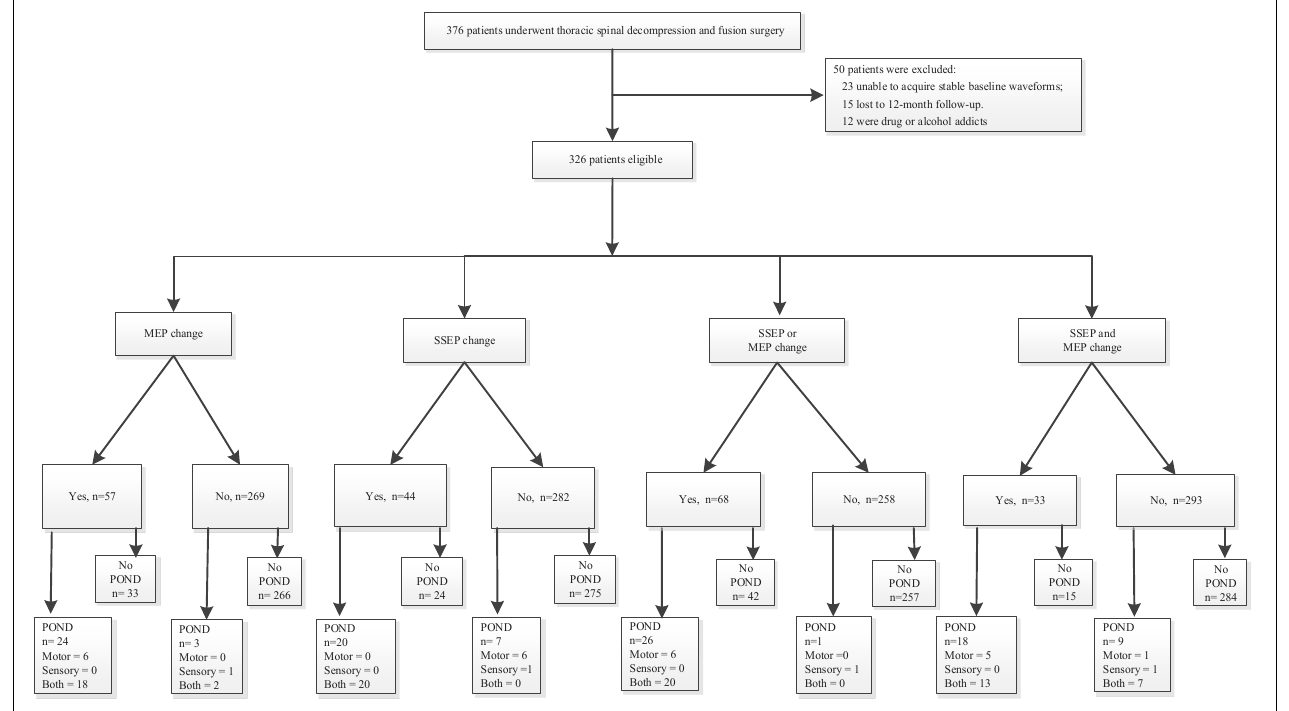
FIGURE 1 | Our study flowchart. PONDs, postoperative neurological deficits; SSEP, somatosensory-evoked potential; MEP, motor-evoked potential.